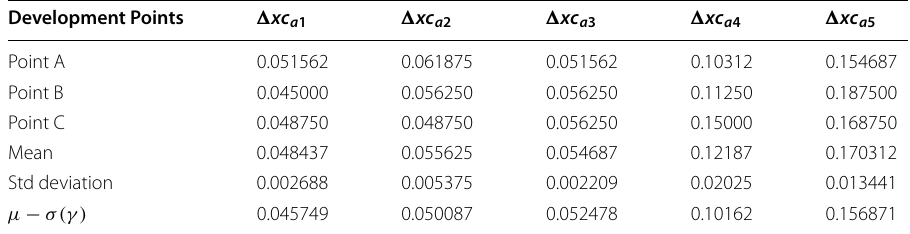
Table 3 Regions of acceptable approximation for 3rd degree Taylor polynomial Development